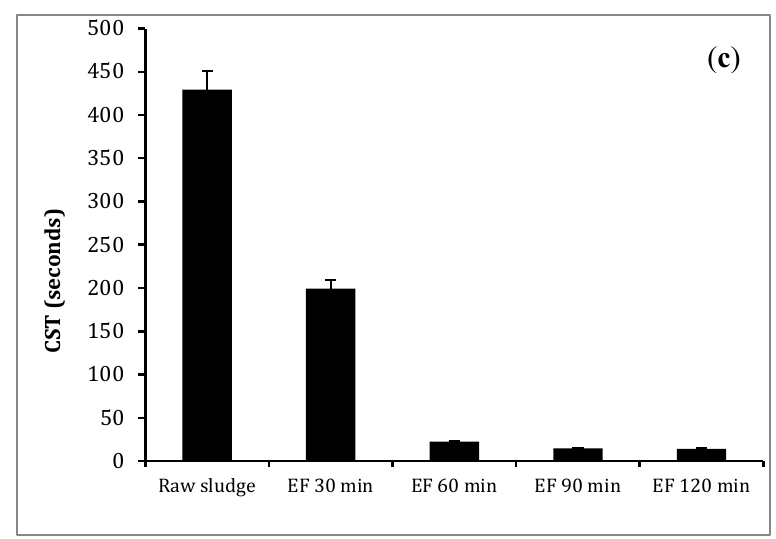
Figure 1. Evolution of soluble and total chemical oxygen demand ( a ), volatile fatty acid concentrations ( b ), and capillary suction time ( c ) during electro-Fenton (EF) pretreatment of WAS.